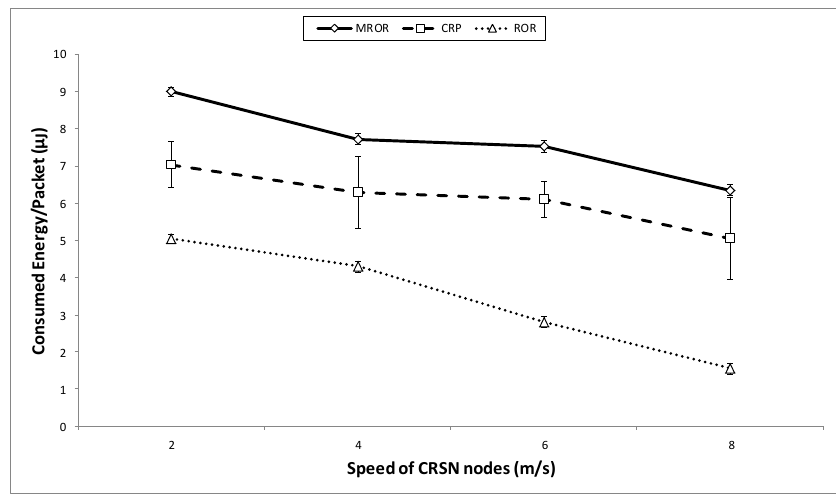
Figure 18. Consumed energy/packet vs . speed of the mobile